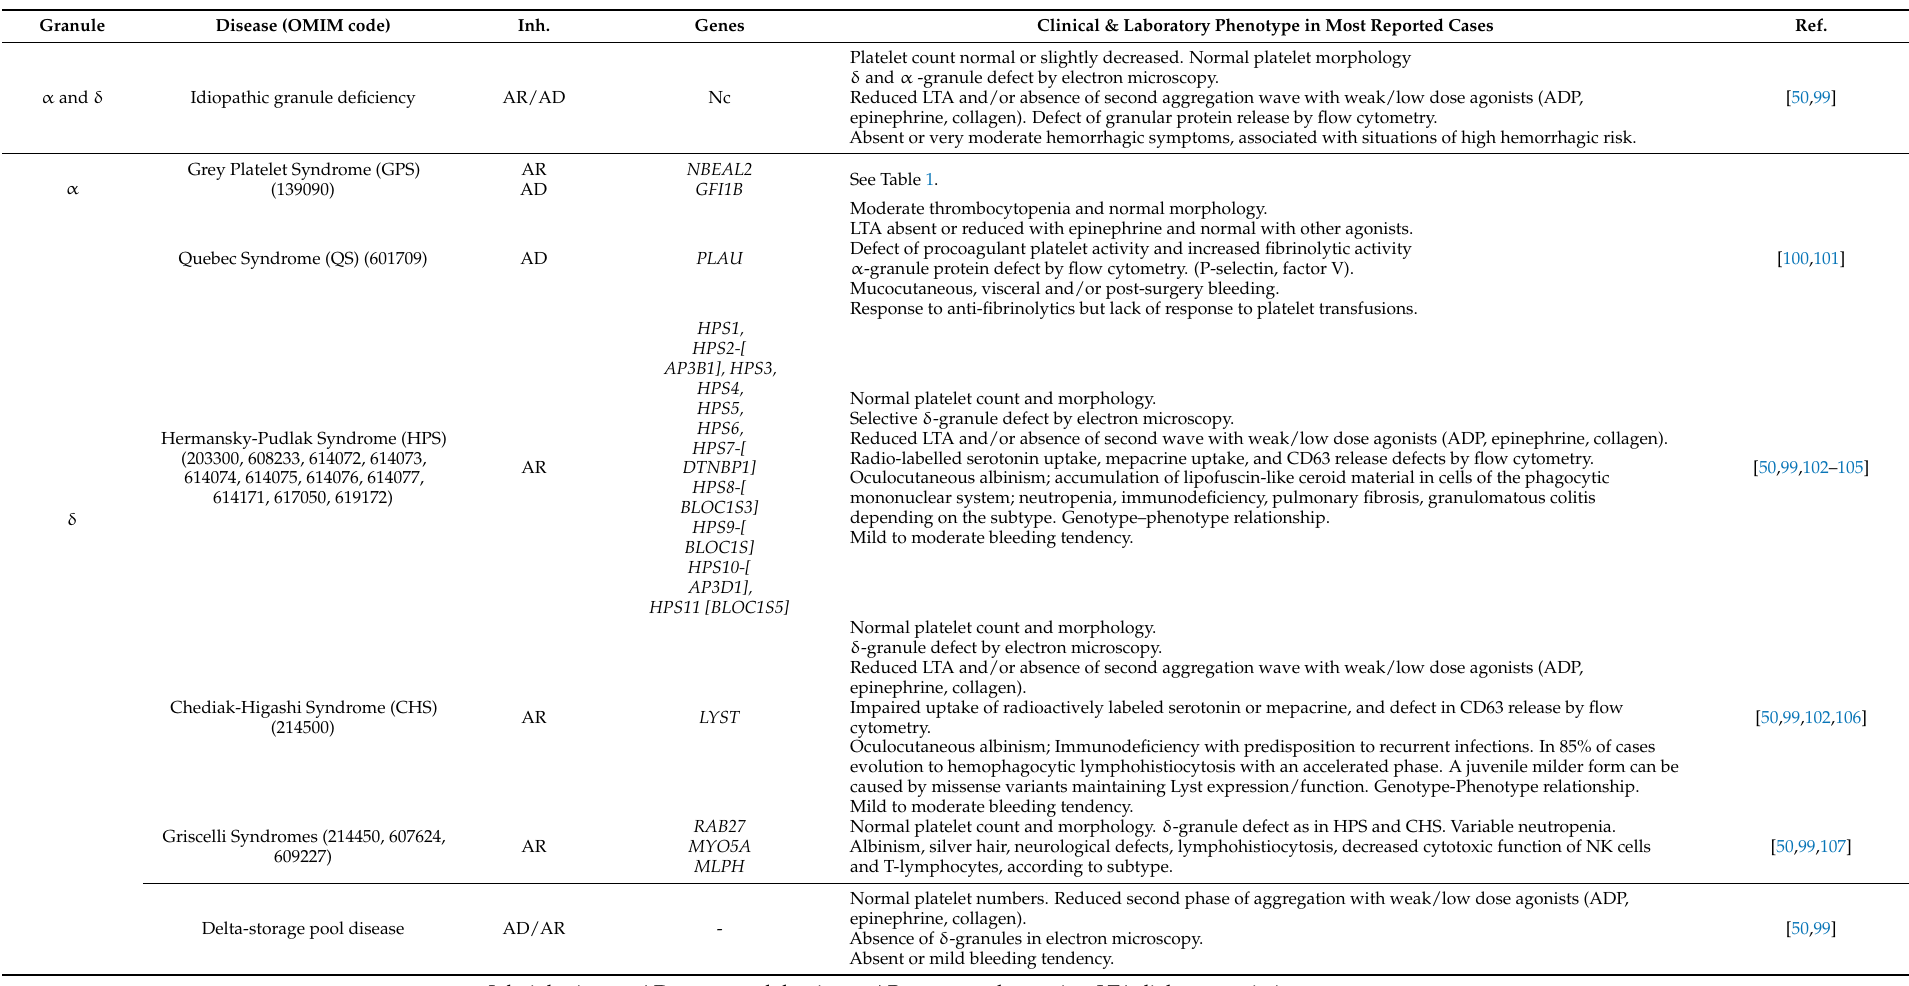
Table 3. Inherited defects of platelet